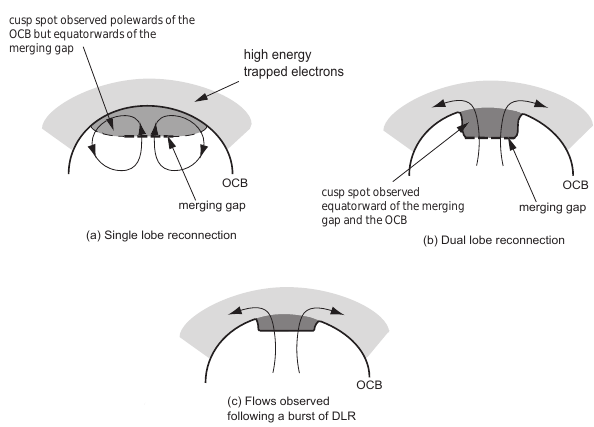
Fig. 6. Schematics of the Northern polar cap with noon to the top of the diagram, thick dashed lines represent the merging gap, solid lines the OCB and the black arrowed lines are flow streamlines. These demonstrate expected particle populations and ionospheric convection for (a) single lobe reconnection where twin reverse cells are observed (b) ongoing dual lobe reconnection where there is sun- ward flow across the dayside OCB (c) magnetospheric reconfigura- tion following dual lobe reconnection, where the OCB is an adiaroic boundary, i.e. there is no flow crossing the OCB.